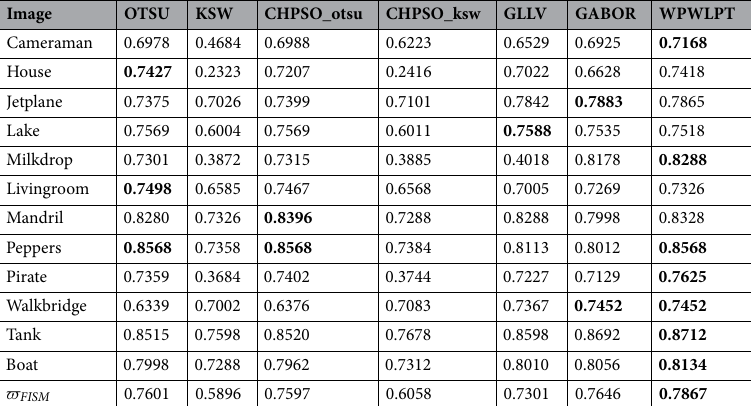
Table 7. FSIMs of the different thresholding methods. The best results are highlighted in bold.